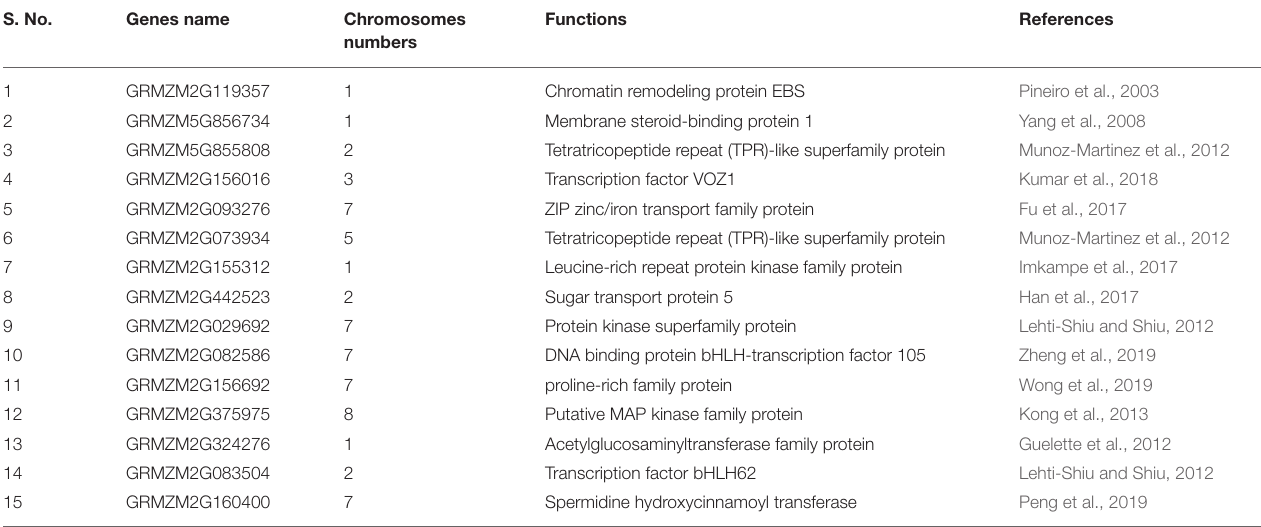
TABLE 2 | Genes involved in lodging resistance and kernel abortion reduction. S. No.